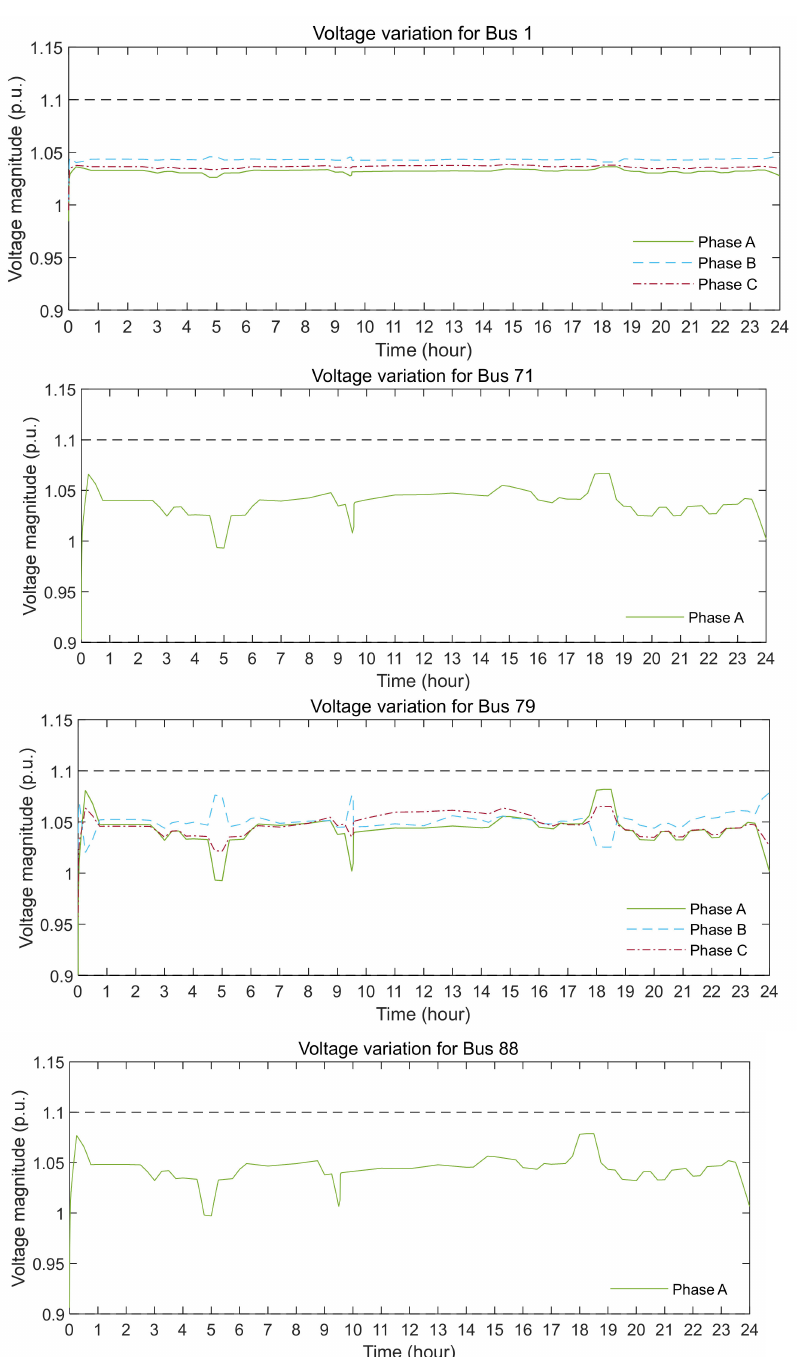
Figure 16. Entire day voltage variations at Buses 1, 71, 79, and 88 for load type